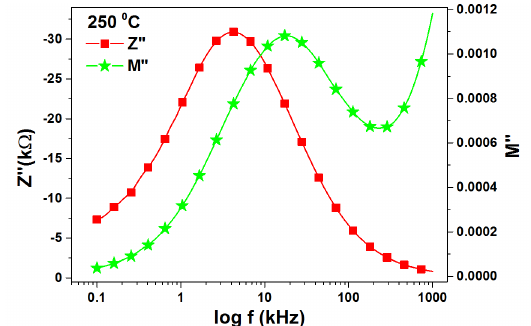
Fig. 11. Variation of relaxation time (calculated from impedance) with temperature.